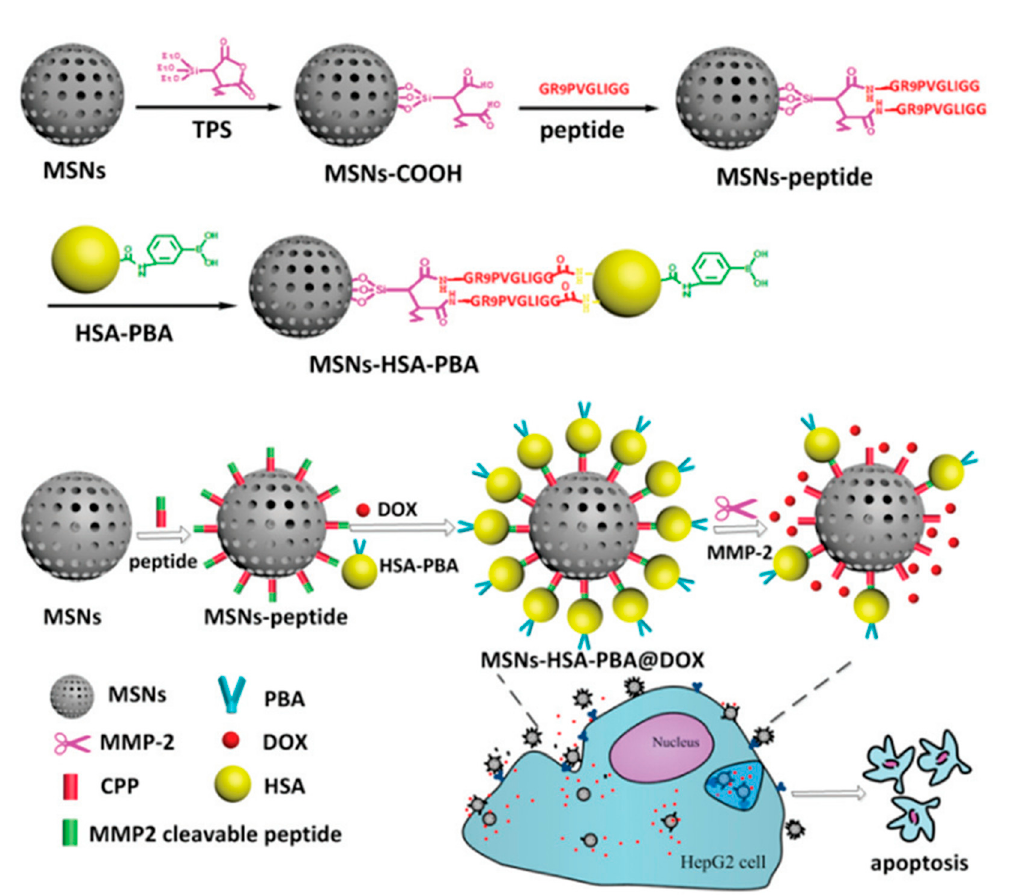
Figure 5. Schematic illustration of the construction of MMP-2 enzyme-responsive mesoporous silica Nanoparticles for the co-delivery of human serum albumin and DOX and its biological effect [99].